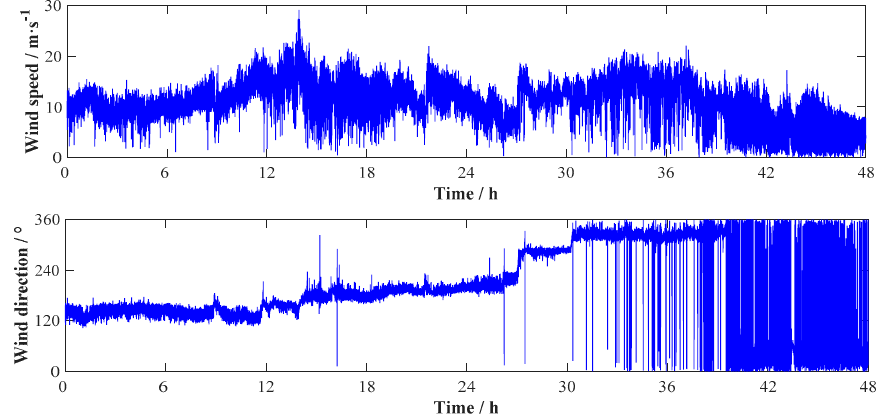
Figure 3. Measured wind samples during Typhoon Soudelor.